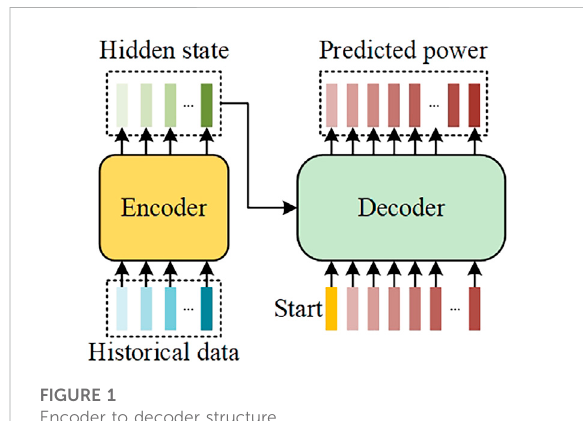
FIGURE 1 Encoder to decoder